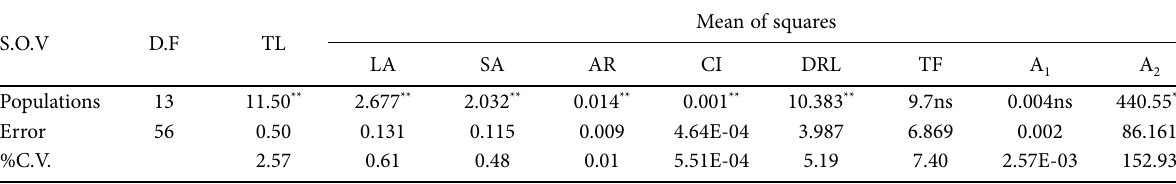
Table 4. The results of variance analysis for karyotypic data based on CRD design.